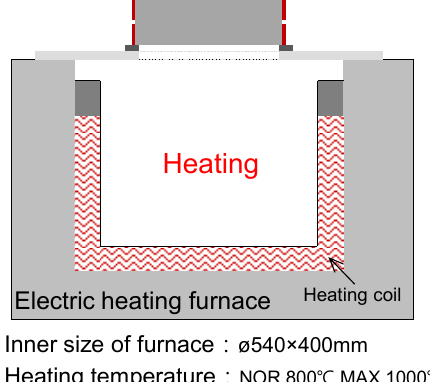
Figure 3. Electric heating furnace schematic and specifications.